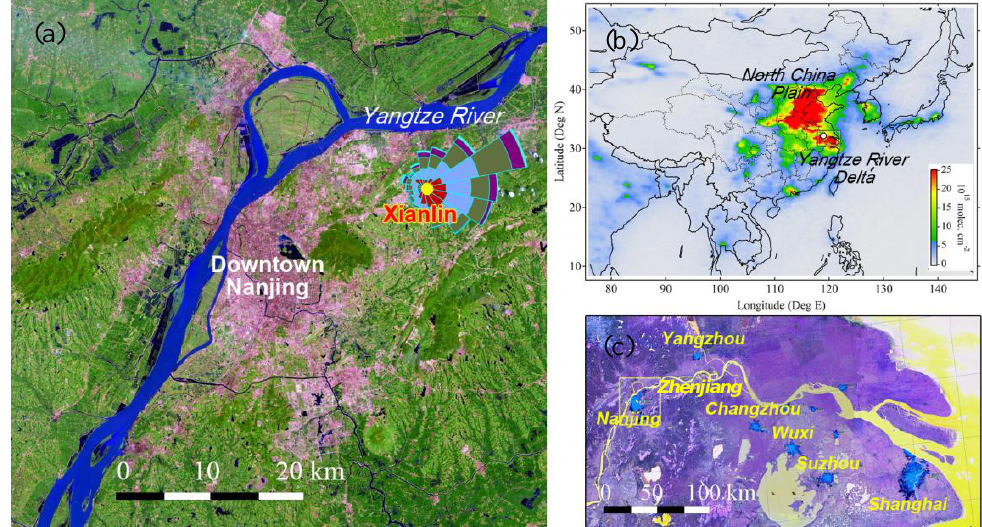
Figure 1. ( a ) A map showing the location of the SORPES Xianlin site. ( b ) Averaged GOME2 tropospheric NO 2 columns for the period of August 2011–July 2012. (c) A map showing cities in the Yangtze River Delta. The GOME2 data were accessed from Tropospheric Emission Monitoring Internet Service of KNMI (Koninklijk Nederlands Meteorologisch Instituut or Royal Netherlands Meteorological Institute).